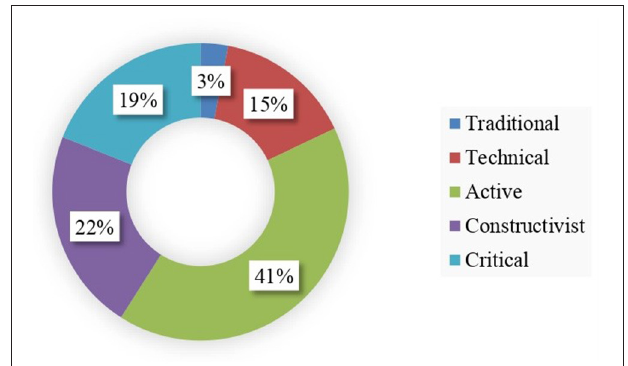
FIGURE 2 | Teacher academic belief